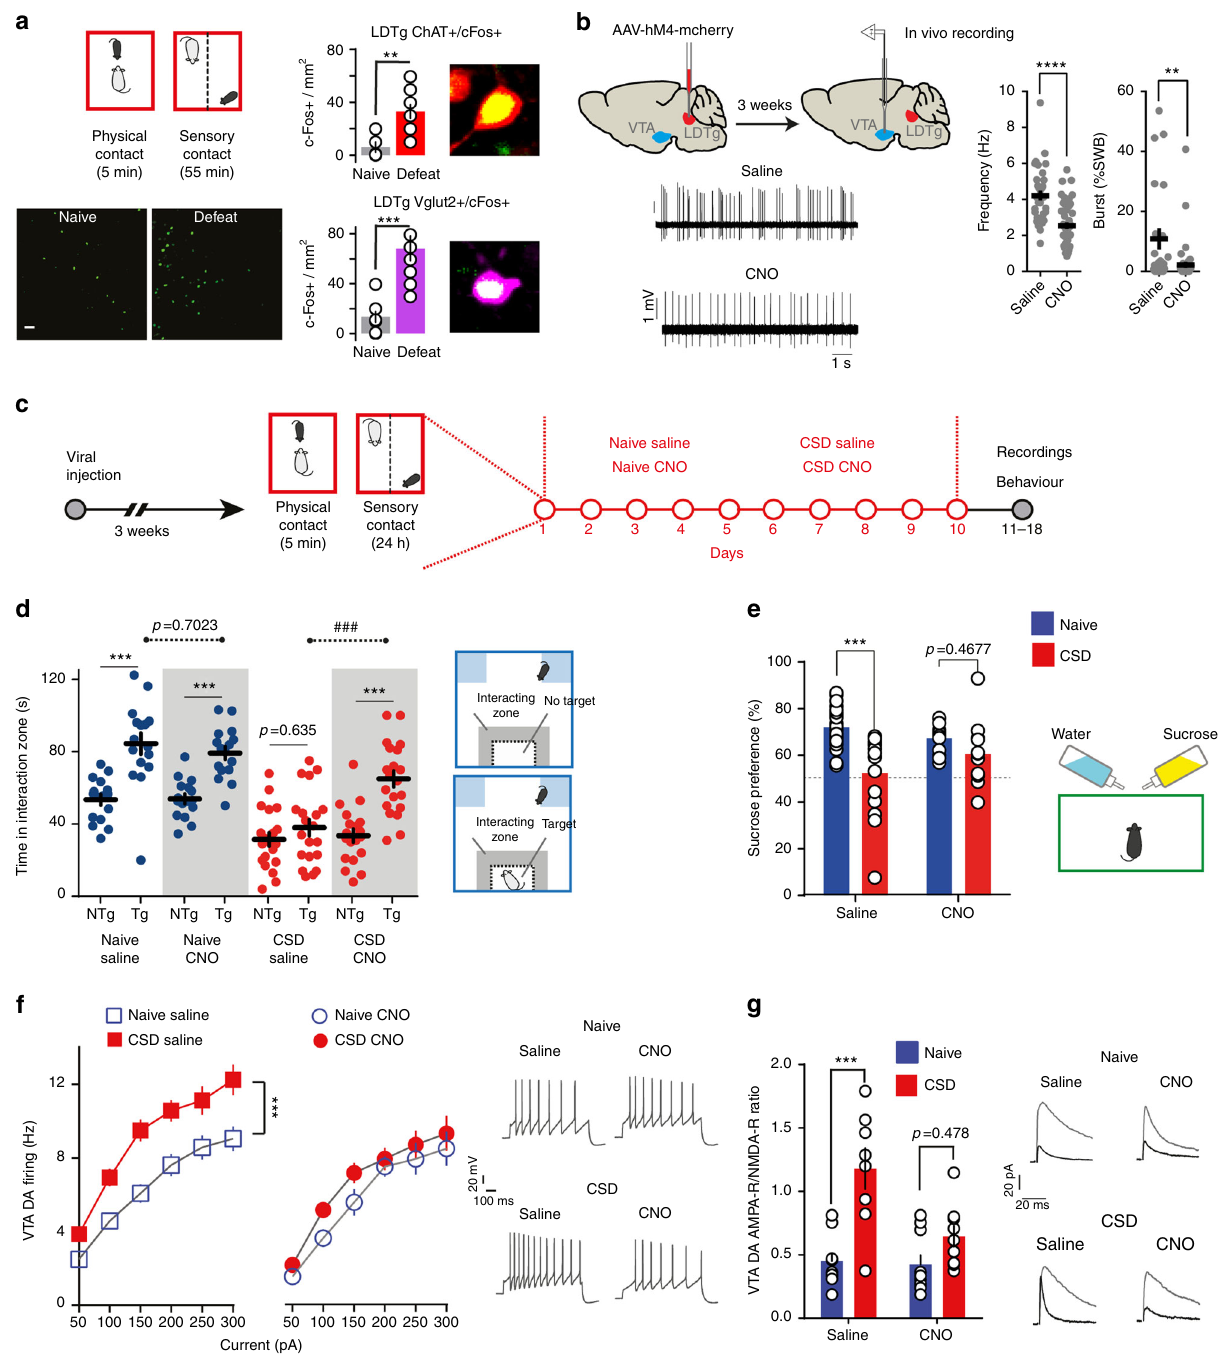
LDTg cholinergic neurons silencing dampens stress impact . To ascertain the individual contribution of LDTg cholinergic and/or glutamatergic neurons to depressive-like behaviors and VTA DA dysregulations, we used a Cre-dependent chemogenetic approach to speci fi cally silence these neuronal populations. First, AAV- hSyn-DIO-hM4-mcherry was stereotaxically injected in the LDTg of ChAT-Cre mice (hereafter called LDTg ChAT-hM4 mice, Fig. 3a and Supplementary Fig. 5a). Selective inhibition of LDTg choli- nergic neurons during CSD prevented the behavioral manifesta- tions of stress. Indeed, although defeated LDTg ChAT-hM4 mice treated with saline showed strong social avoidance and anhedonic responses to sucrose solution, CNO-treated LDTg ChAT-hM4